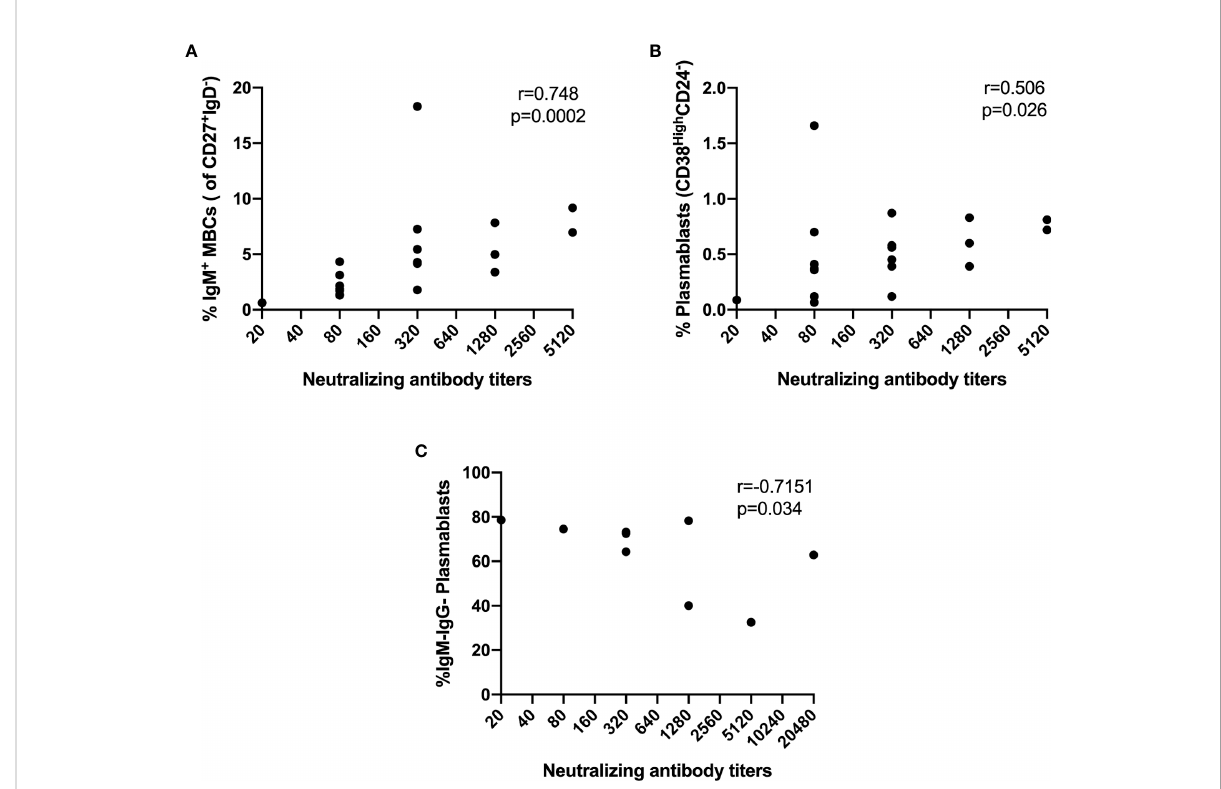
FIGURE 7 Correlations between NAbs and frequencies of B cells subsets. (A) IgM + Switched MBCs from asymptomatic, (B) PB from asymptomatic, (C) IgM - IgG - PB from symptomatic. Spearman ’ s correlation coef fi cient (r) and p-value are